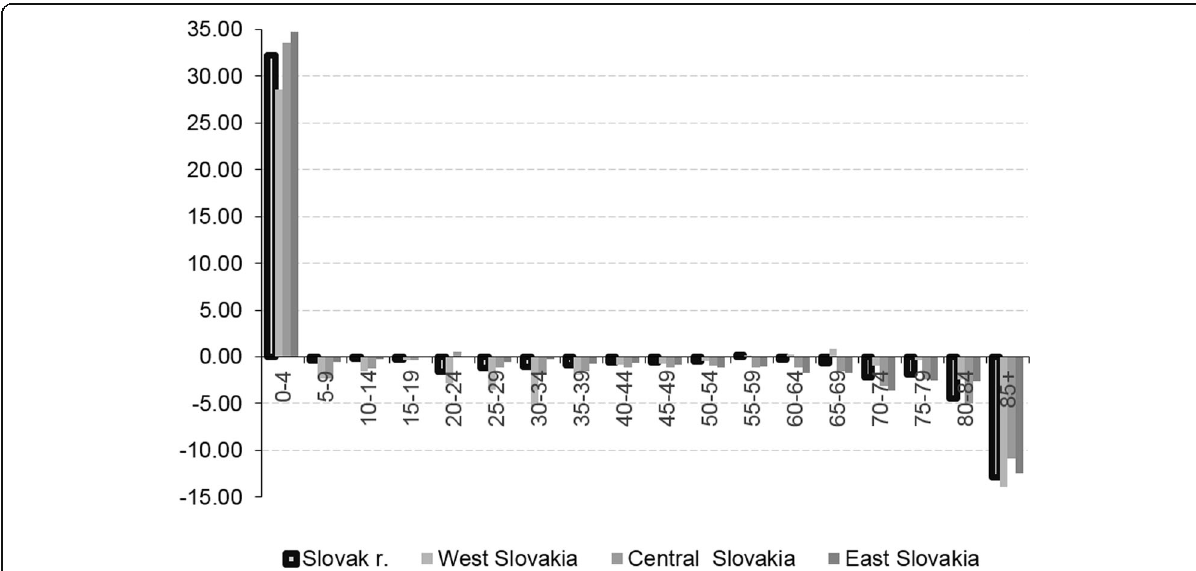
Fig. 2 Percentage error of population size by age in regions of the Slovak Republic. Source: [16], authors ’ simulation. Note: districts existing until 1996, calculated for year 2000 (6 years after